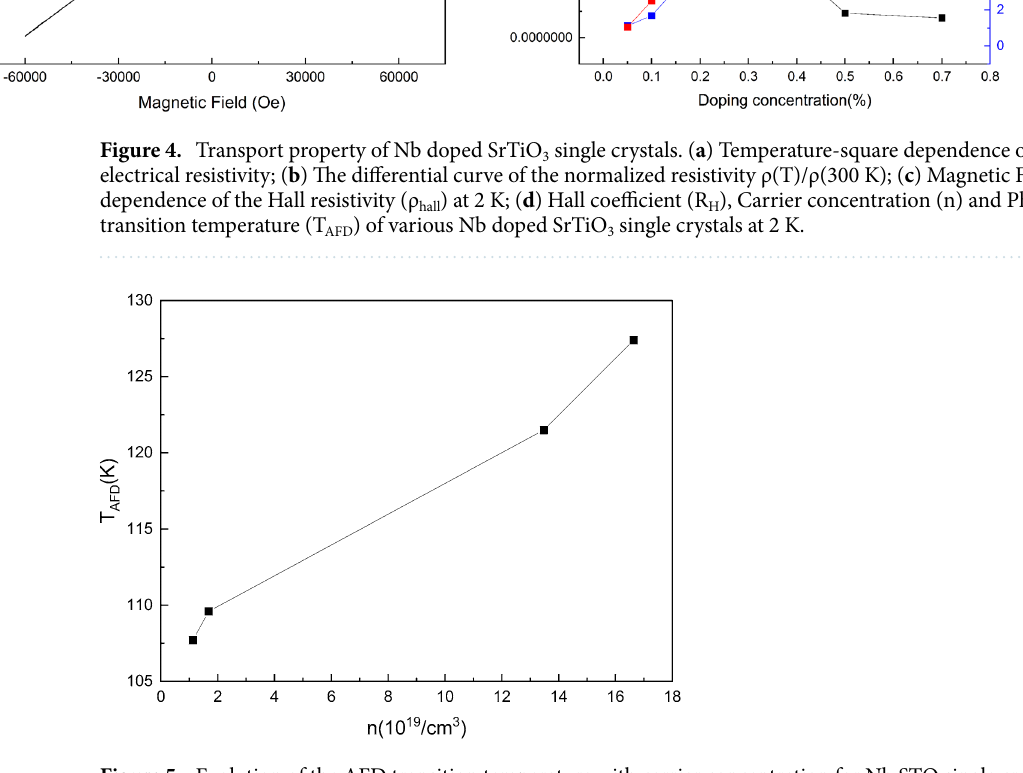
Figure 5. Evolution of the AFD transition temperature with carrier concentration for Nb:STO single